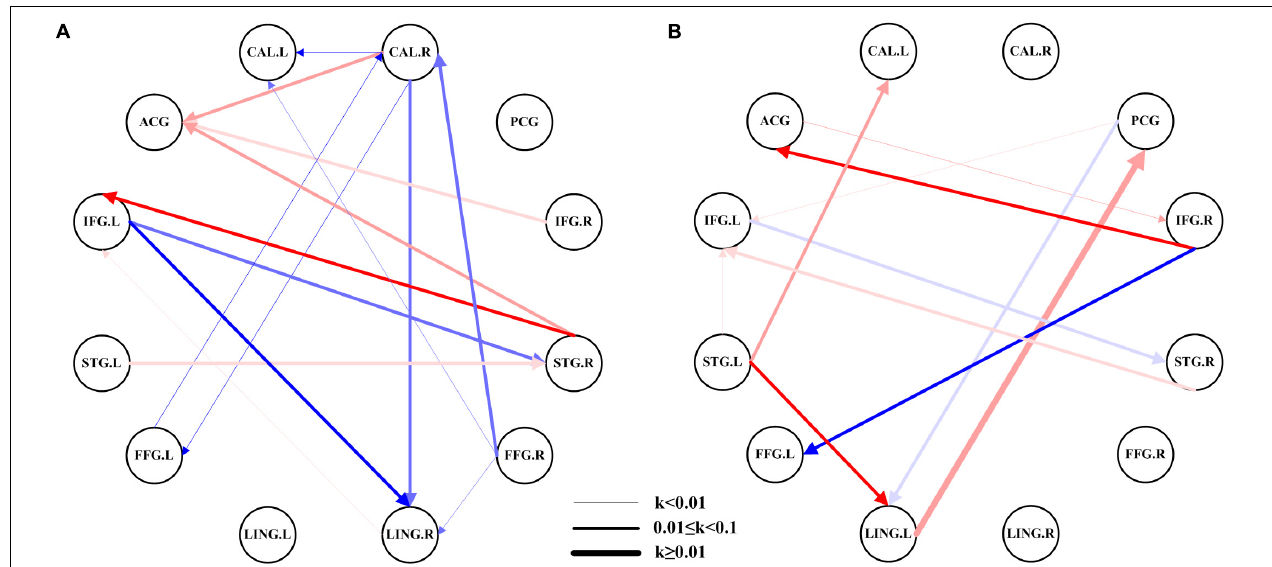
FIGURE 2 | EC network within the groups using ROI-wise EC. (A) EC network of ROIs in patients with amblyopia. (B) EC network of ROIs in the HCs. The color shades represent significance of EC (0 < P < 0.015, 0.015 ≤ P ≤ 0.03, and 0.03 < P ≤ 0.05); red represents excitation, blue represents inhibition, and the arrow indicates the direction of connection. The thickness of the line represents the connection strength (weak: k < 0.01, medium: 0.01 ≤ k < 0.1, strong: k ≥ 0.1). CAL.L, left calcarine fissure; CAL.R, right calcarine fissure; ACG, anterior cingulate gyrus; PCG, posterior cingulate gyrus; IFG.L, left inferior frontal gyrus; IFG.R, right inferior frontal gyrus; STG.L, left superior temporal gyrus; STG.R, right superior temporal gyrus; FFG.L, left fusiform gyrus; FFG.R, right fusiform gyrus; LING.L, left lingual gyrus; LING.R, right lingual